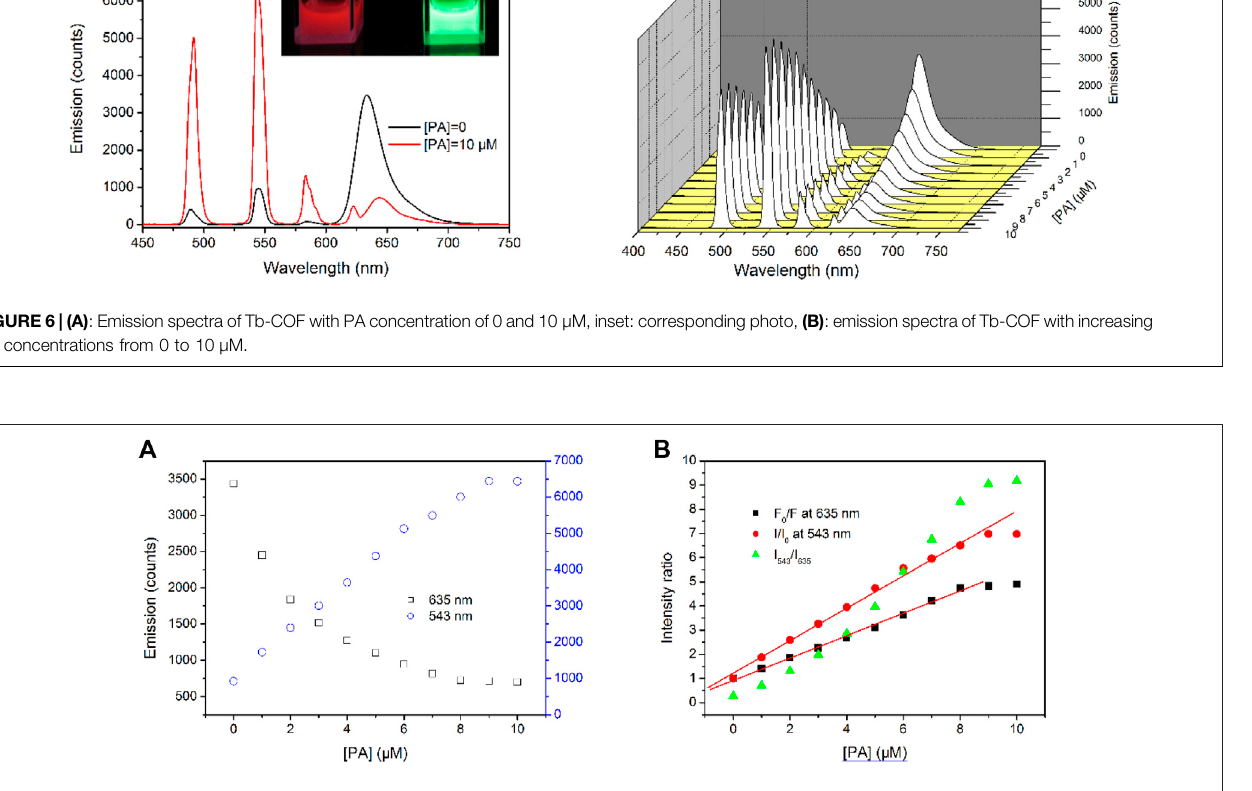
FIGURE 7 | (A) Emission intensity variation at 543 and 635 nm of Tb-COF with increasing PA concentrations from 0 to 10 μ M, (B) intensity ratios of F 0 /F, I/I 0 , and I 543 /I 635